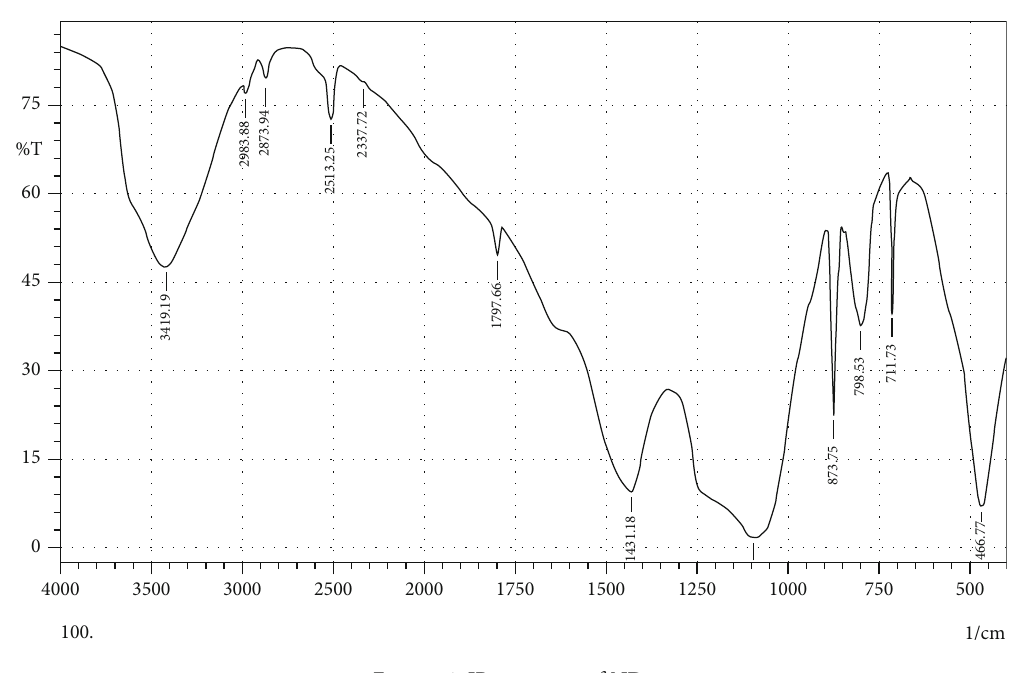
Figure 3: Composition of ND by EDX.